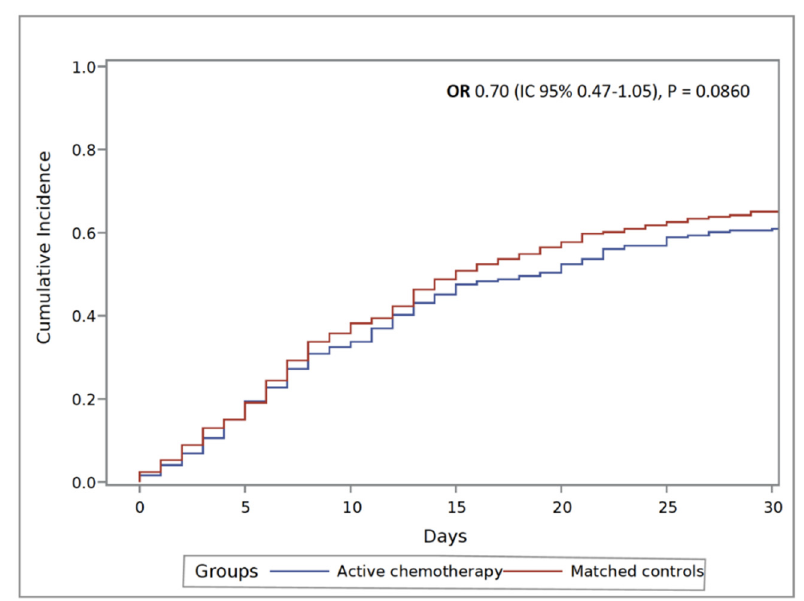
Figure 2. Cumulative incidence of death in cancer patients under active chemotherapy and non-active chemotherapy pair-matched controls.